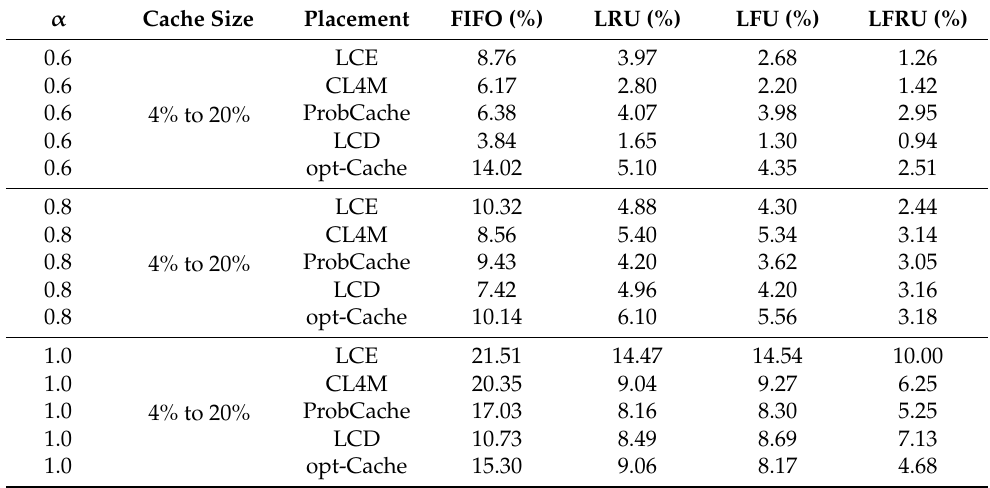
Table 11. IMU path stretch percentage improvement.